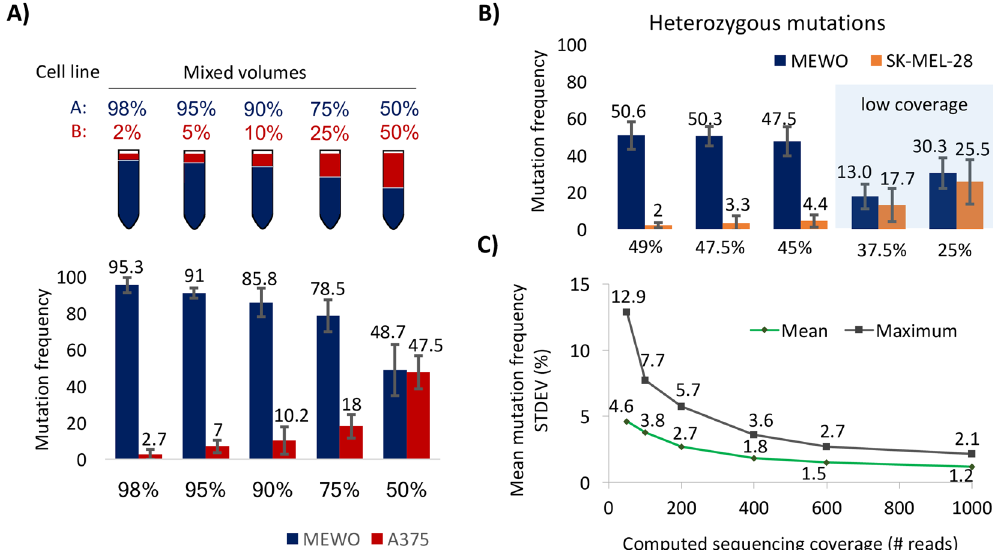
Figure 4. Correlation between cellular composition and mutation frequencies using next-generation sequencing. Calibration sequencing frequencies of the A375 and MEWO cell lines using homozygous mutations ( A ). Calibration sequencing frequency results of the SK-MEL-28 and MEWO pairs calculated from heterozygous mutations ( B ). Mean (green) and maximal (grey) mutation frequency standard deviations obtained from permutation test based on different coverages ( C